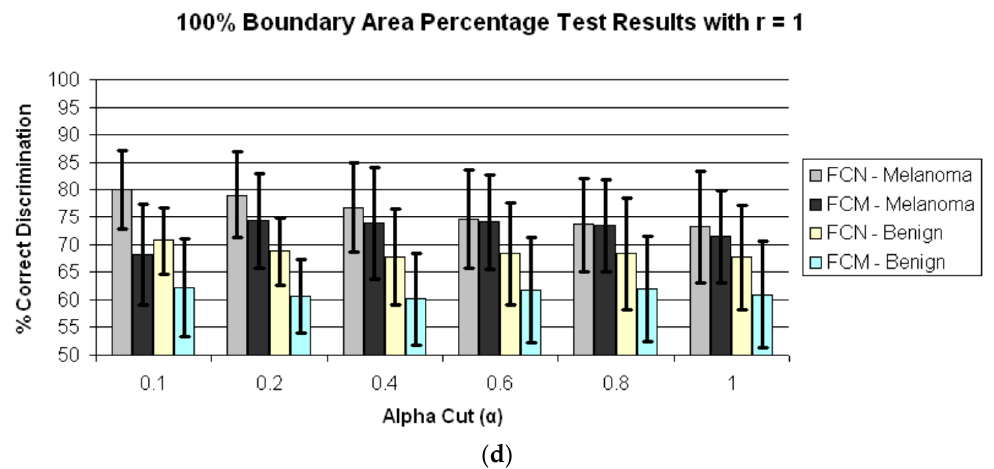
Figure 5. Average and standard deviation test results over 25 randomly generated training/test sets for different boundary area percentages for r = 1. FCN and FCM denote the fuzzy ratio features computed using the benign and melanoma training images to determine discrimination accuracy. ( a ) Boundary area percentage = 10%; ( b ) Boundary area percentage = 25%; ( c ) Boundary area percentage = 75%; ( d ) Boundary area percentage = 100%.